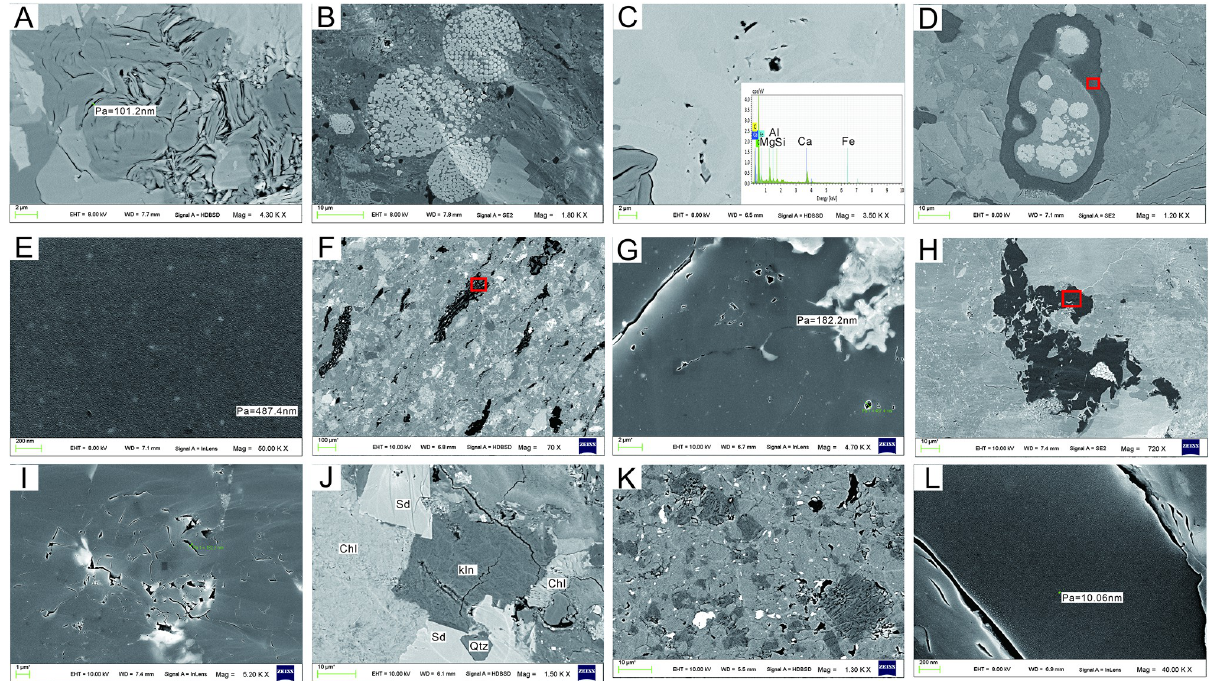
Fig 6. Distribution characteristics of microscopic reservoir space in shale samples of the Longtan Formation. (A) Sample 8#: Interlayer fractures developing in lamellar clay minerals ( × 4300); (B) Sample 2#: Framboidal pyrite aggregations showing parts of the intercrystal pore filled with clay minerals ( × 1800); (C) Sample 5#: Irregular dissolution pores in siderite (confirmed by energy spectrum) ( × 3500); (D) Sample 4#: Interior of crustal organic matter filled with micro-granular and framboidal pyrite, as well as clay minerals ( × 1200); (E) Enlarged view of Sample 4# in Fig 9D, showing the development of little pores ( × 50000); (F) Sample 9#: Interstitial organic matter interbedded with clay minerals and siderite (720 × ); (G) Enlarged view of Sample 9# in Fig 9F, with pores and fractures developed ( × 5200); (H) Sample 12#: The sample structure is tight, clastic, interbedded with clay minerals and organic matter, with fragmentary or interstitial organic matter ( × 70); (I) Enlarged view of Sample 12# in Fig 9H. Irregular pores and microfractures developed in fragmentary organic matter ( × 4700); (J) Sample 9: Microfractures ( × 1500), Sd: siderite, Chl: chlorite, Kln: kaolinite, Qtz: quartz; (K) Sample 12#: Micro-granular quartz in inlying contact interbedded with lamellar kaolinite aggregations; intergranular pores and fractures developed ( × 1300); (L) Sample 14: No pores observed in banded organic matter, but shrinkage fractures developed at edges of organic matter ( ×